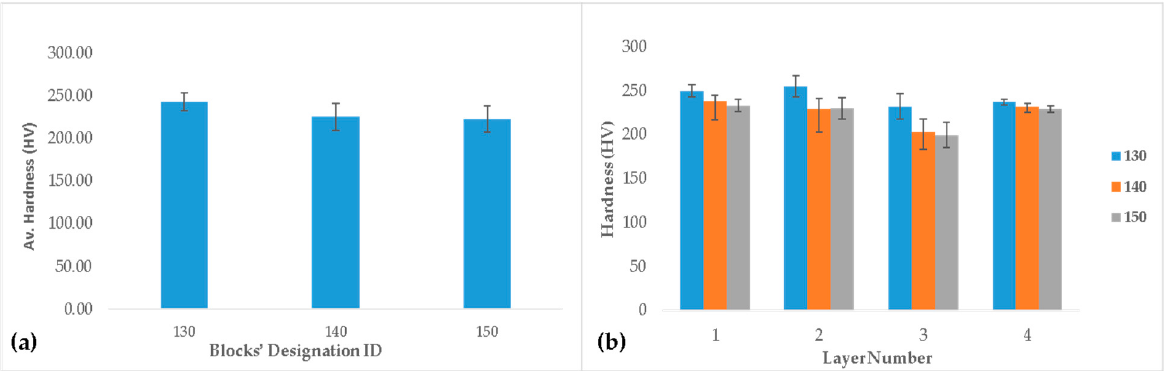
Figure 6. Bar charts displaying the hardness values. ( a ) Average values and ( b ) layer-by-layer values for the 130, 140, and 150 built blocks.